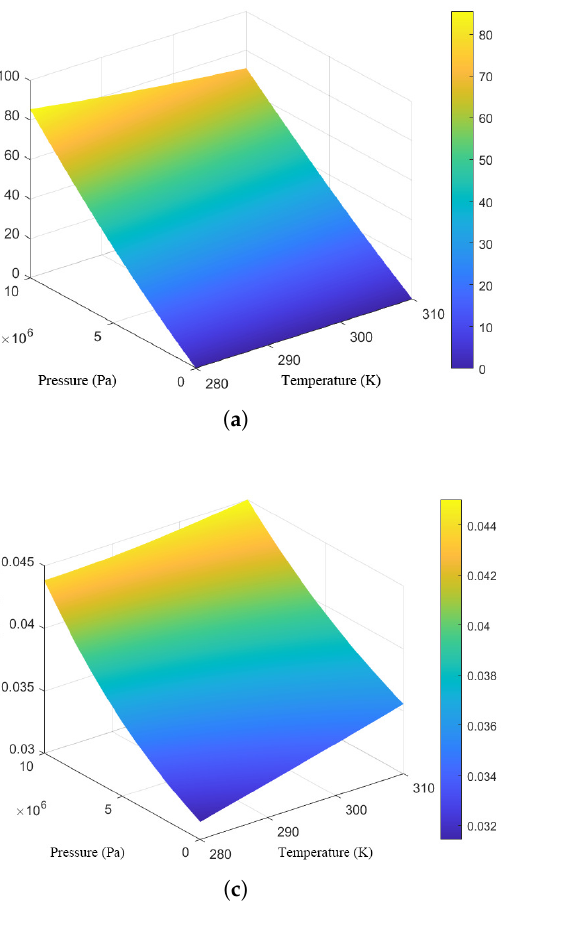
Figure 1. CH 4 ( a ) density, ( b ) specific heat capacity, ( c ) thermal conductivity and ( d ) dynamic viscosity as a function of